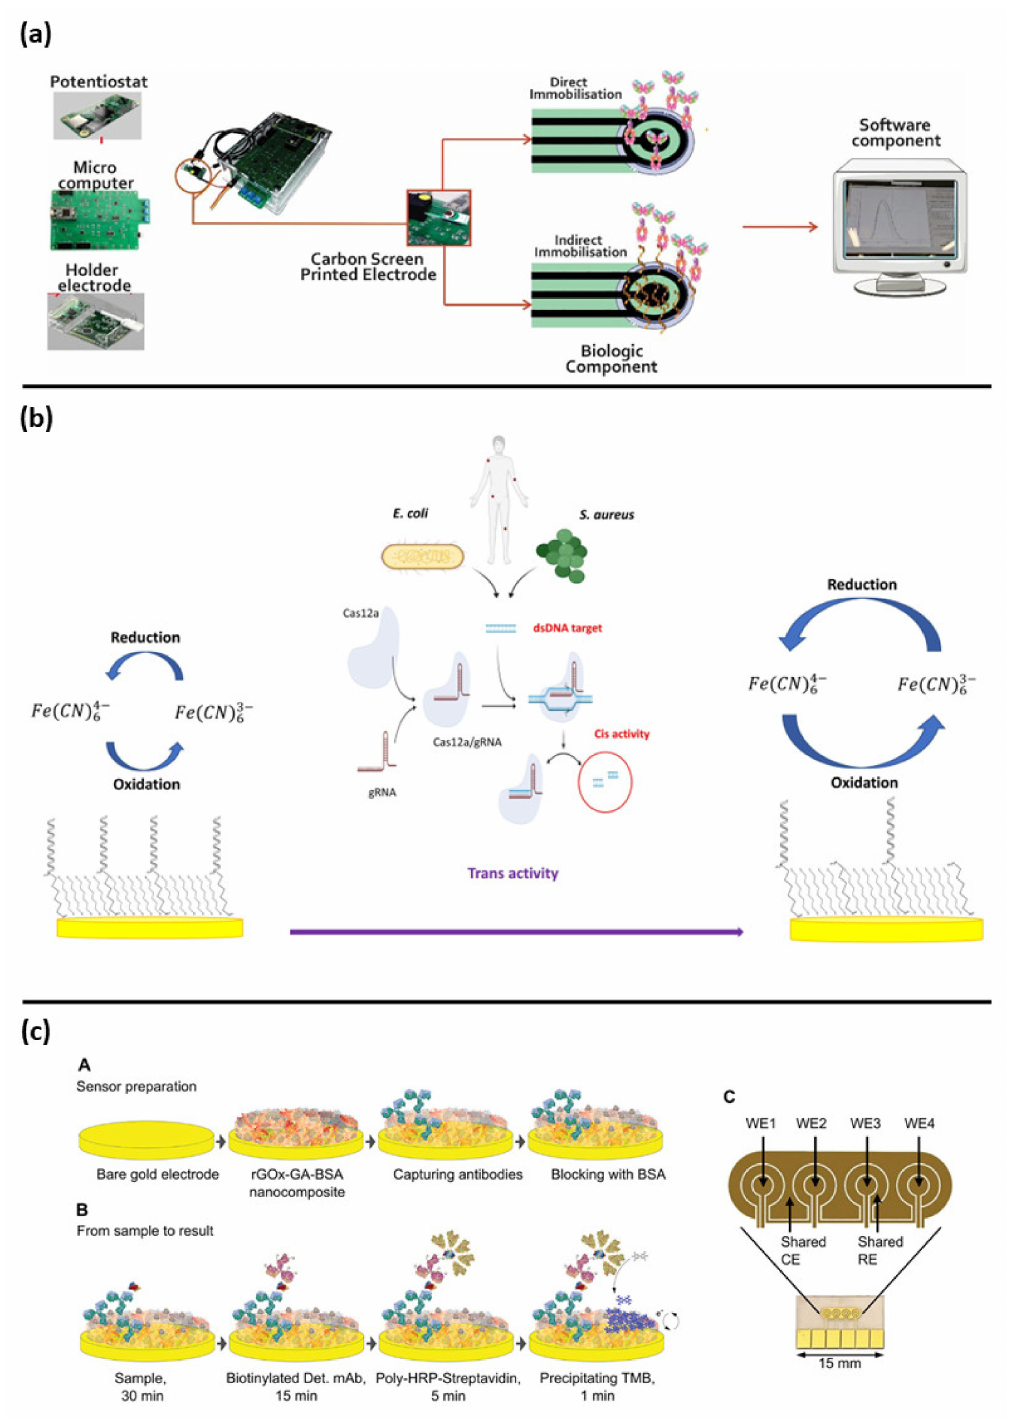
Figure 3. Examples of electrochemical biosensors approaches for sepsis diagnosis: ( a ) representa- tion of all components of point of care biosensor for CRP detection, reprinted from [68] Creative common CC BY 4.0; ( b ) assay schematic of CRISPR/cas12a based biosensor for E. coli and S. aureus detection, reprinted with permission of [81], copyright 2021 Elsevier B.V.; ( c ) fabrication steps and electrode schematic for PCT and CRP detection, reprinted with permission [73], copyright 2021 Wiley-VCH